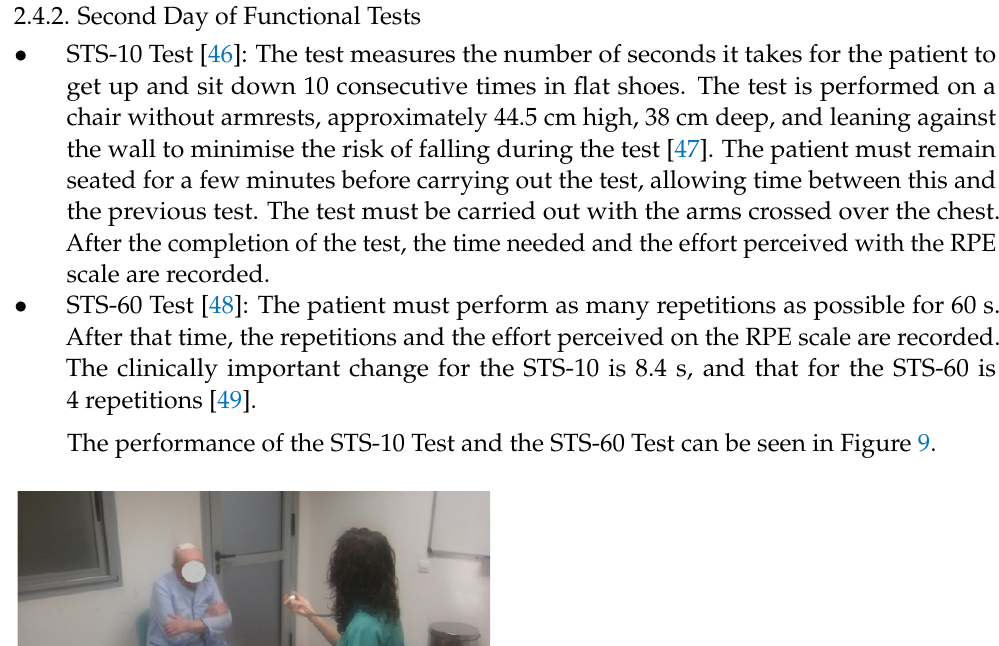
Figure 8. Timed Up and Go Test (reproduced with permission from Erika Meléndez-Oliva 2020) [43].